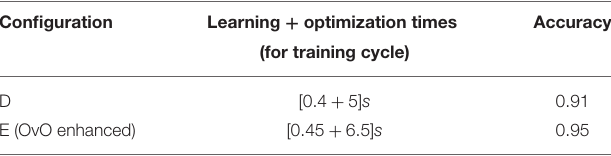
TABLE 5 | Comparison of one-versus-one (OvO) performances obtained with the two methodologies implemented (best accuracies).